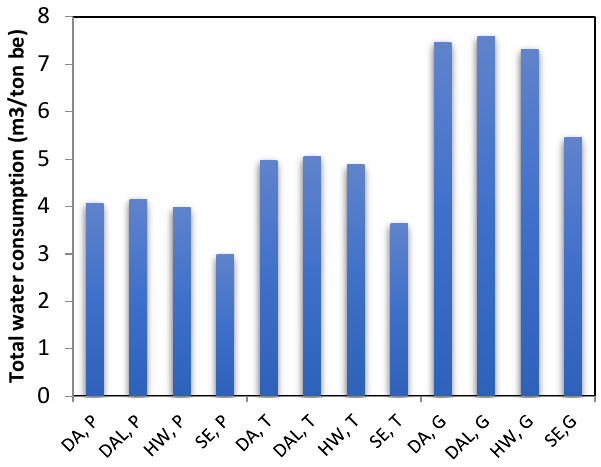
Figure 7. Total water consumption for 1 ton of bioethanol produced by using different wastes.